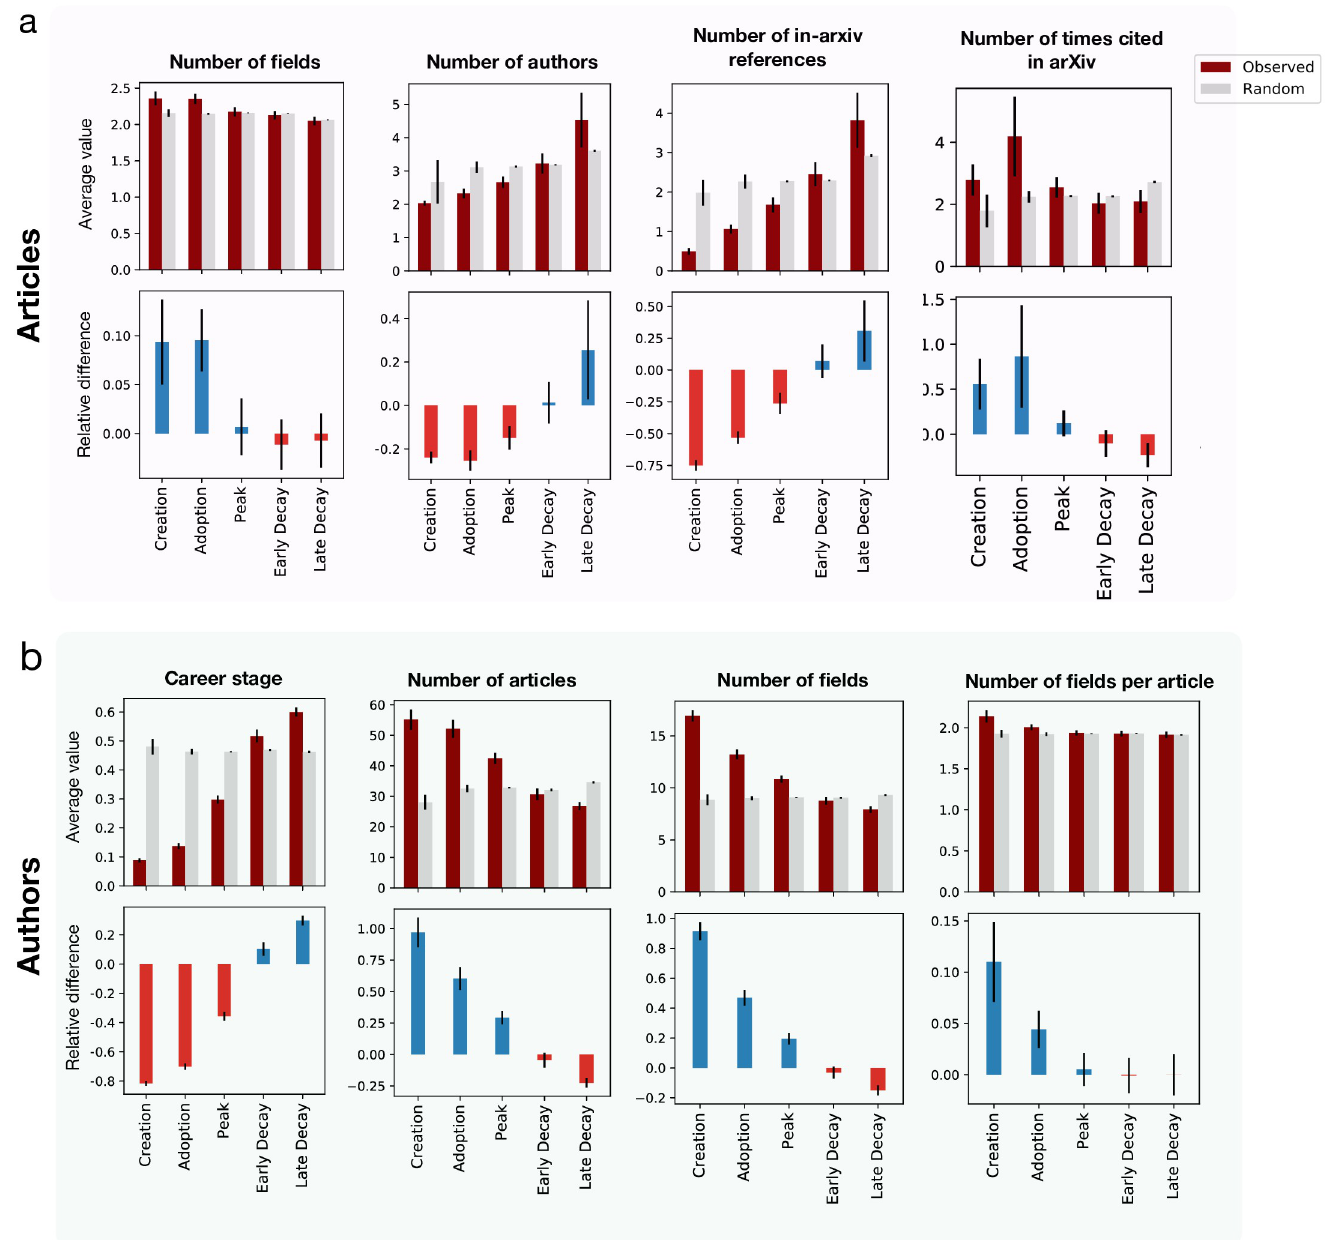
Fig 3. Evolution stages. Characteristics of articles and authors at different evolutionary stages. The observed values are averaged over all fields (red bars). Gray bars correspond to the average field-specific random expectation (see Methods). Bottom plots represent the relative difference between observed and random values. Error bars denote standard errors for observed values (red) and standard deviation for random values (gray). a Article-centric features: number of fields reported in the article (multidisciplinarity), number of authors (team size), number of references made to other arXiv articles, and number of citations received within arXiv (impact). b Author centric features: career stage within arXiv at the time of submitting the article, total number of articles submitted to arXiv (longevity), number of fields their articles span during their career and average number of fields per article (multidisciplinarity).